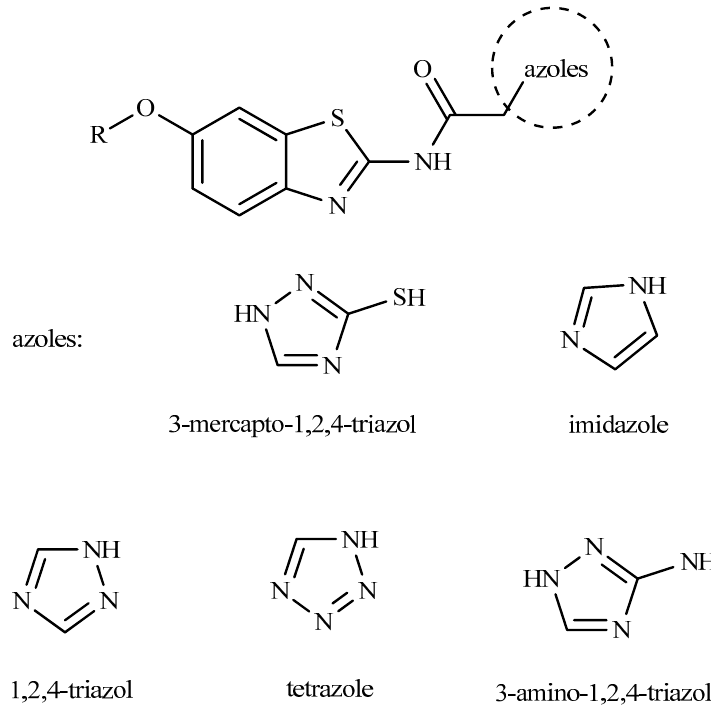
Figure 1. Benzothiazole and kinds of azoles combined with amide.